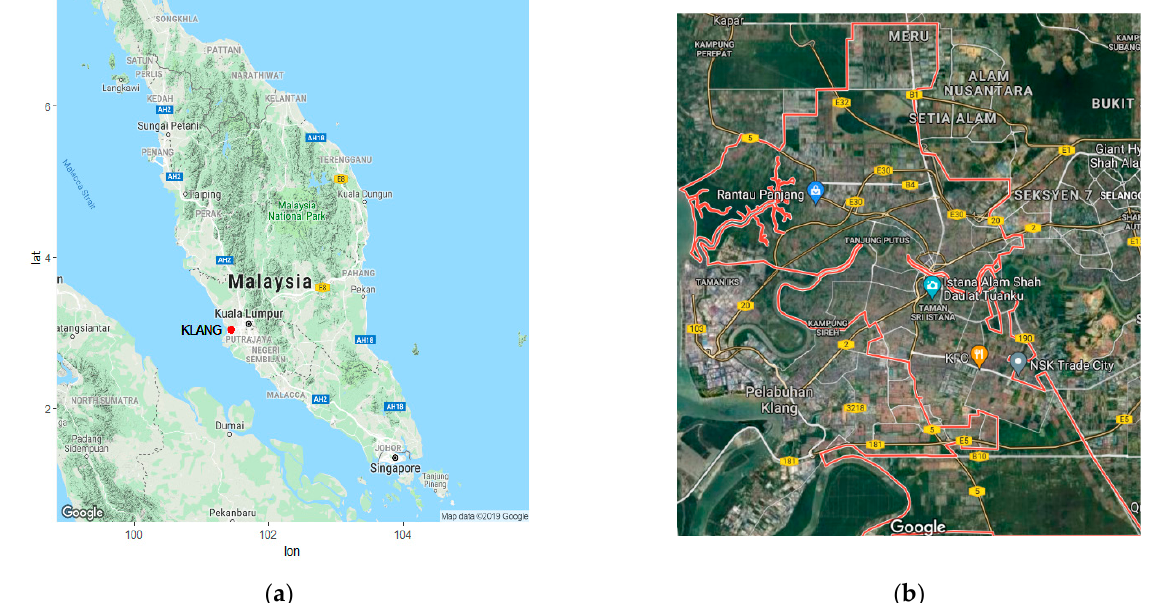
Figure 1. ( a ) Map of Peninsular Malaysia (Klang is identified by the red dot); ( b ) map of Klang.